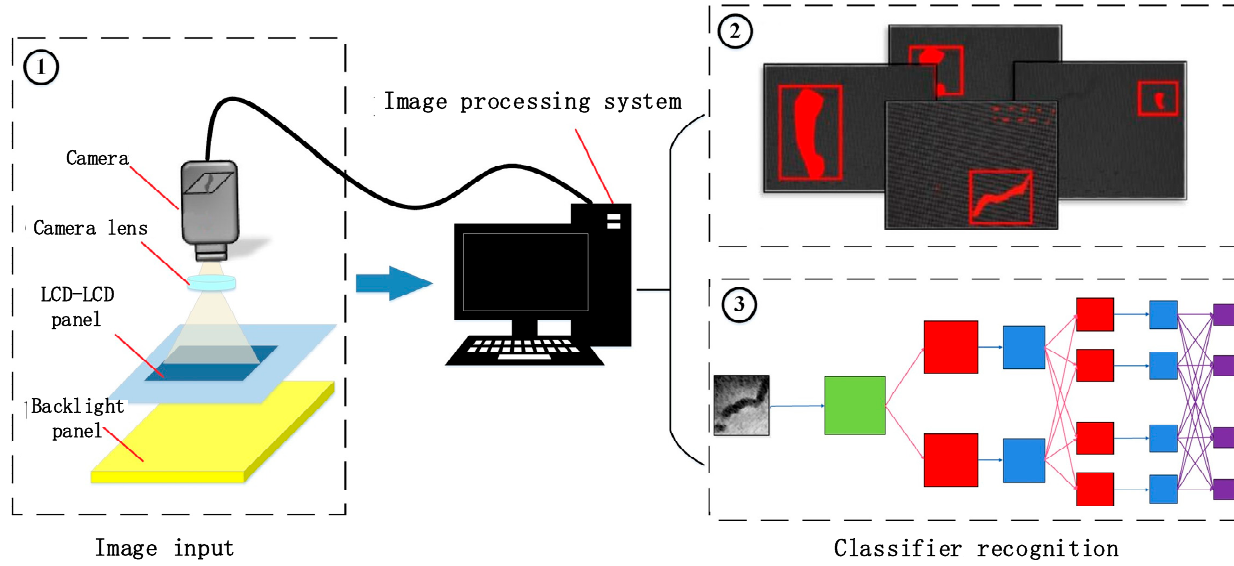
Figure 6. Flow chart of automatic optical inspection of TFT-LCD Mura defect [3]. Reprinted with permission from ref. [3], Copyright 2017 Huazhong University of Science and